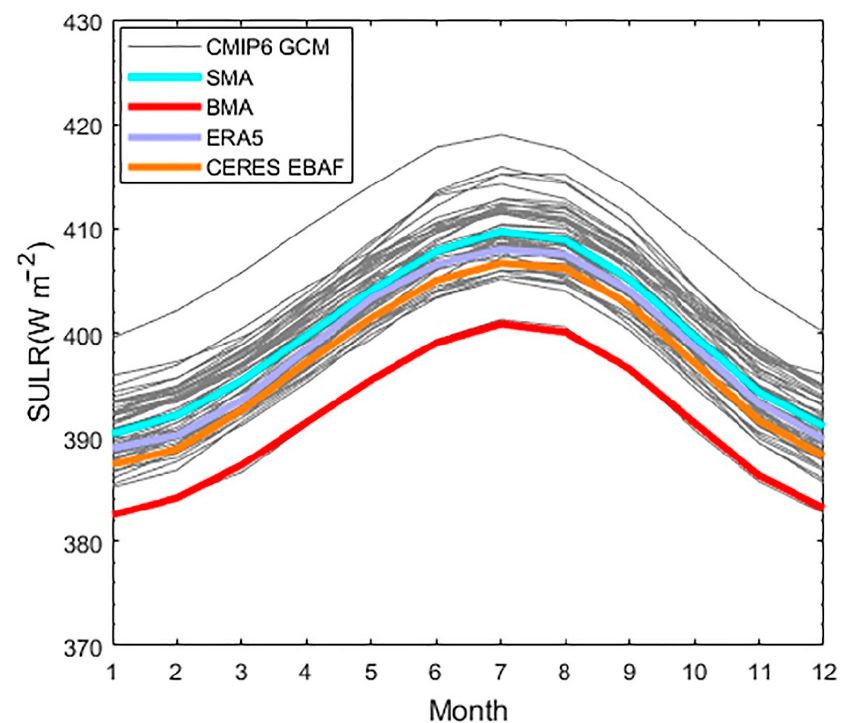
Figure 8. Temporal variations in the SULR estimations of the 51 CMIP6 GCMs, the SMA method, the BMA method, the ERA5 and the CERES EBAF from 2000 to 2005 (in units of W m − 2 ).